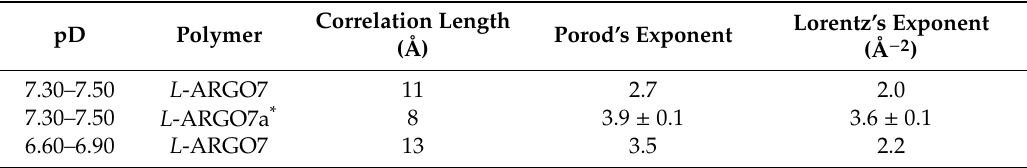
Table 3. Parameters obtained for 5 mg mL − 1 NaDC / water / L -ARGO7 system at various pD using the shape independent mathematical function: correlation length, Porod’s and Lorentz’s exponents. All values have a standard deviation lower than